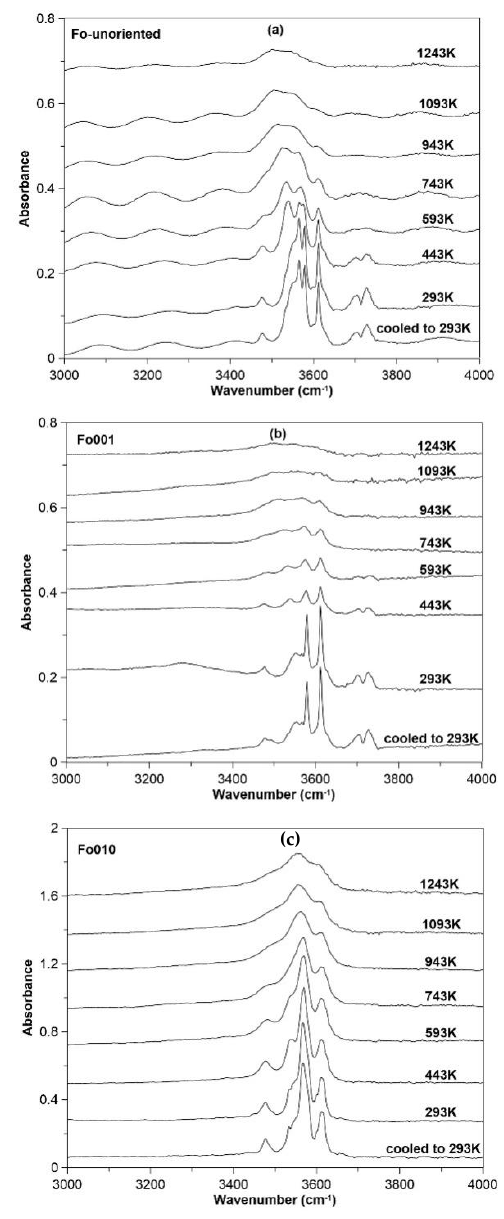
Figure 5. Selected unpolarized IR spectra for the Fo-unoriented ( a ), oriented Fo001 ( b ) and Fo010 ( c ) samples at elevated temperatures.